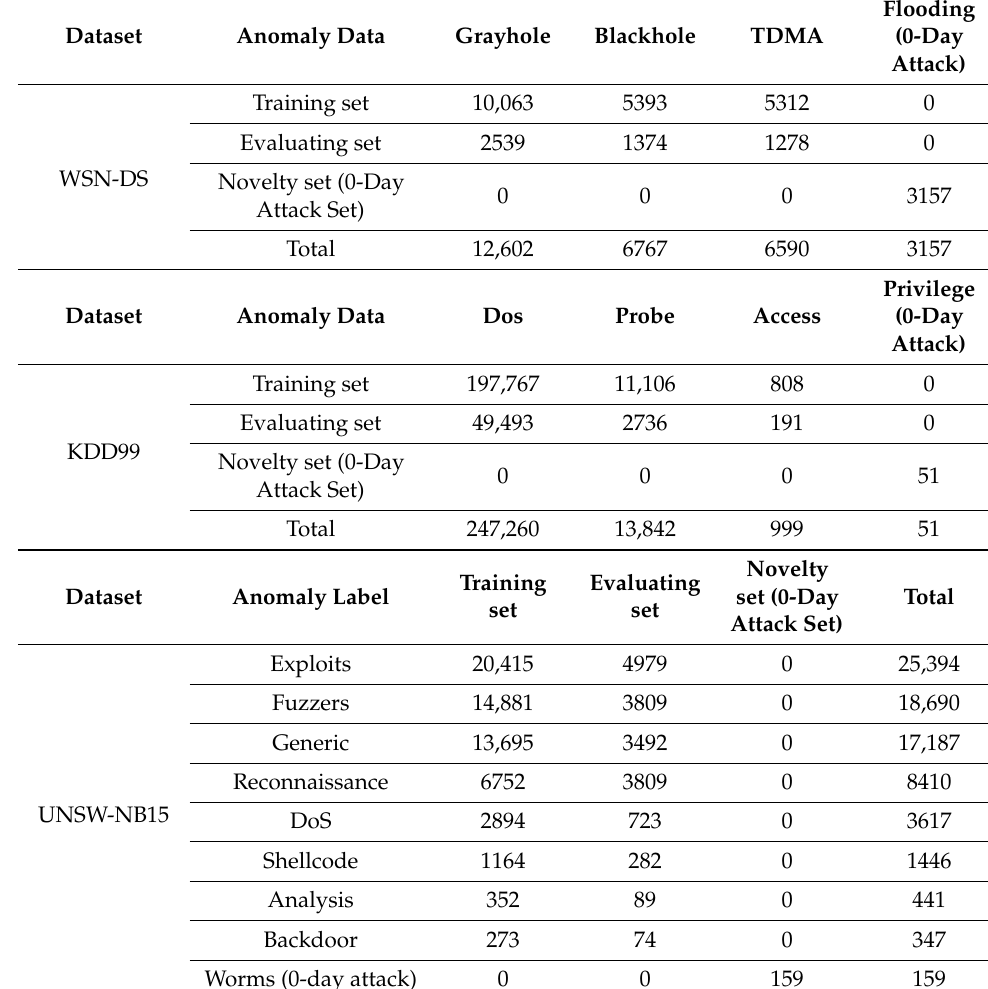
Table 11. Attack data